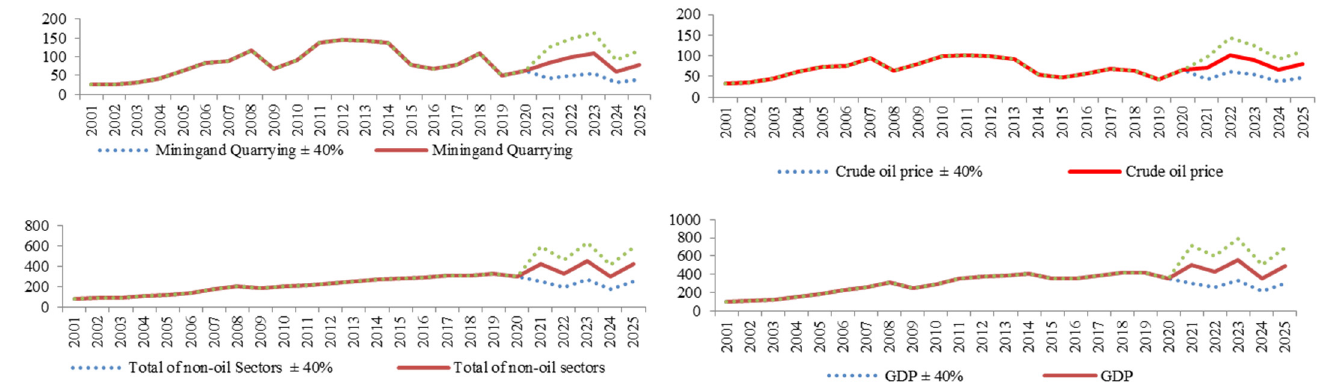
Figure 7 . Forecasting results on the UAE macroeconomic indicators; the dependent variable is the crude oil price.